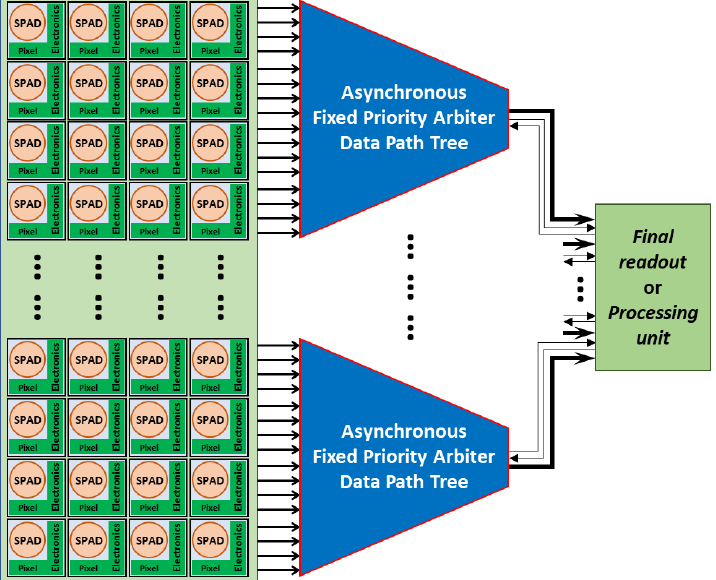
Figure 1. Synoptic of a possible SPAD array readout system using the proposed asynchronous FPA tree. The SPAD pixels generate some data that are extracted from the array thanks to the FPA. To highlight how such a circuit can be implemented with a SPAD sensor, two sce- narios are proposed and presented in Figure 2. In each case, the SPADs and their associ- ated electronics are connected to the input of the FPA tree, but a different type of data can be generated by the SPAD pixel. In case 1, the SPAD array is used as an event-based sensor